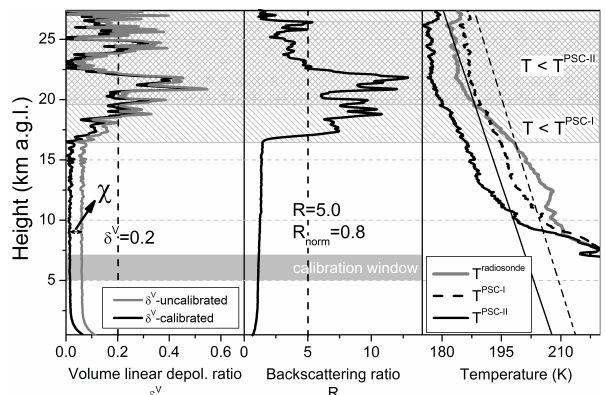
Fig. 4. An example of calibration of the volume linear depolariza- tion ratio δ V . From left to right: 1h-averaged (01:00–02:00UTC) δ V profile on 1 July 2009, once calibrated (black line) and be- fore calibration (gray line); the corresponding backscattering ratio R profile; and the closest available temperature radiosounding on 29 June 2009 at 11:00UTC (gray line). The threshold temperatures for PSC-I ( T PSC-I ) and PSC-II ( T PSC-II ) formation are also shown assuming: 10-ppbv HNO 3 and 5-ppmv H 2 O (thin dashed and solid lines, respectively) as typical values for June (Maturilli et al., 2005), and the in situ water vapor concentration profile (radiosonde data) (thick dashed and solid lines, respectively). Calculations have been performed using the parameterizations of Hanson and Mauers- berger (1988) for PSC-I, and Marti and Mauersberger (1993) for PSC-II. CALIPSO ground-track distance was 3.6km from the Bel- grano II station on this